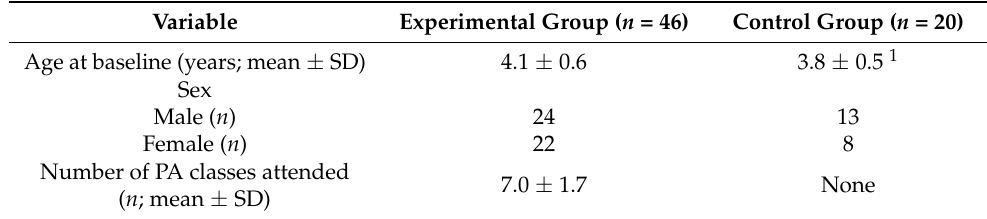
Table 1. Demographic information of